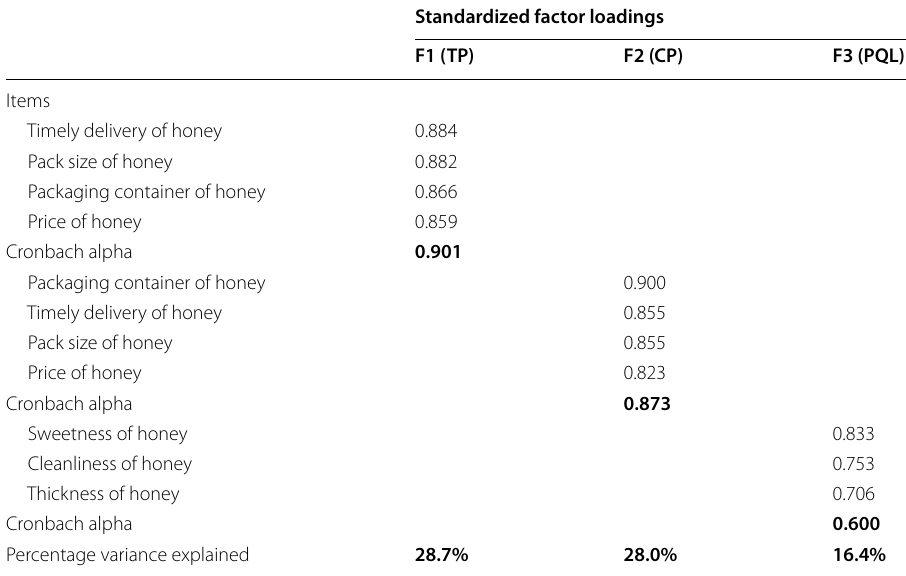
The bold figures are for the cronbach Alpha values of the major Factor loading Total variance explained product quality